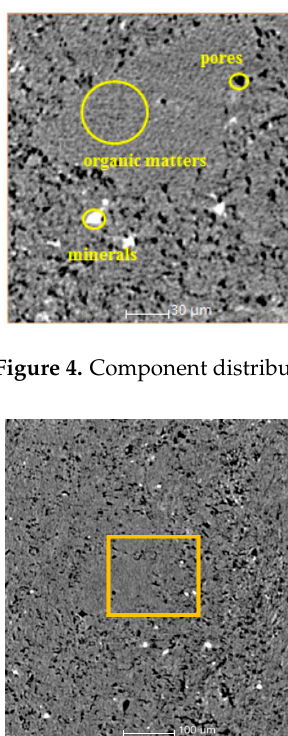
Figure 5. Original Pore image.